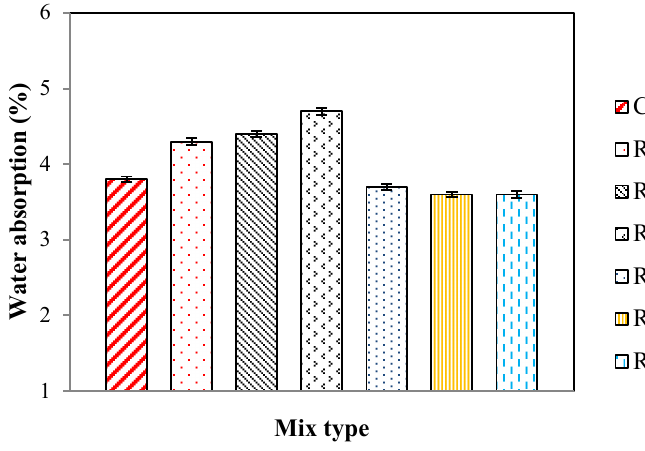
Figure 5. Water absorption of concrete samples at 28 days.